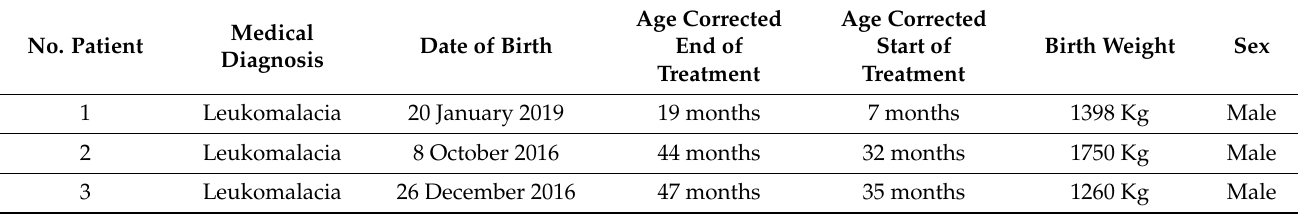
Table 1. Characteristics of study